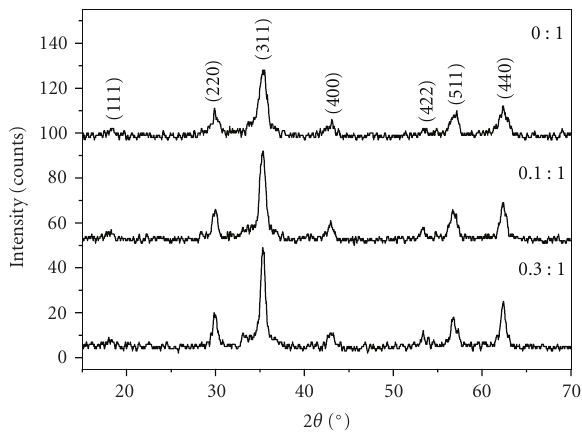
Figure 1: XRD patterns of the powders synthesized with di ff erent molar ratios of CMC monomer to metal ions.